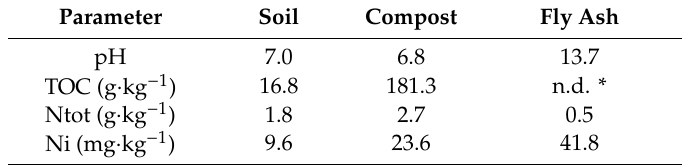
Table 1. Basis properties of soil, compost and fly ash (data for composite